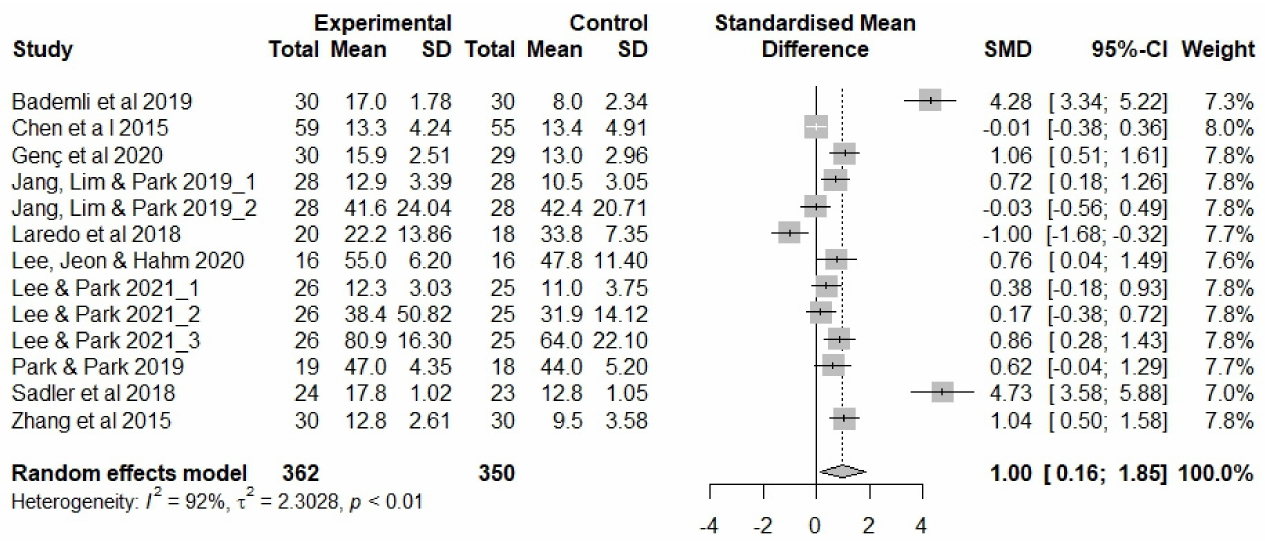
Figure 3. Forest plot showing the effects of non-pharmacological interventions. SD, standard deviation; SMD, standard mean difference [14,15,37,39,40,43–46,49]. Two studies that applied auricular acupressure presented the mean/SD for deep sleep duration [14,15] and melatonin concentrations [15] in addition to sleep quality; these measurements were also included in the meta-analysis. We analyzed 13 outcome measures. The effects of non-pharmacological sleep interventions in the studies included in the meta-analysis (n = 712 participants) were as follows (Figure 3). The estimated average effect size (Hedge’s g) was 1.00 ( p = 0.020) in the random effects model, showing that older adults’ sleep increased by an SD of 1.00 following non-pharmacological intervention. The confidence interval (CI) did not include 0 (95% CI 0.16, 1.85), and the null hypothesis of no effect was rejected (Z = 2.33, p = 0.020). Thus, the evaluated non-pharmacological sleep interventions were deemed effective in older adults. There was a high degree of heterogeneity in the included studies (I 2 = 92%, Q = 155.4, df = 12, p <